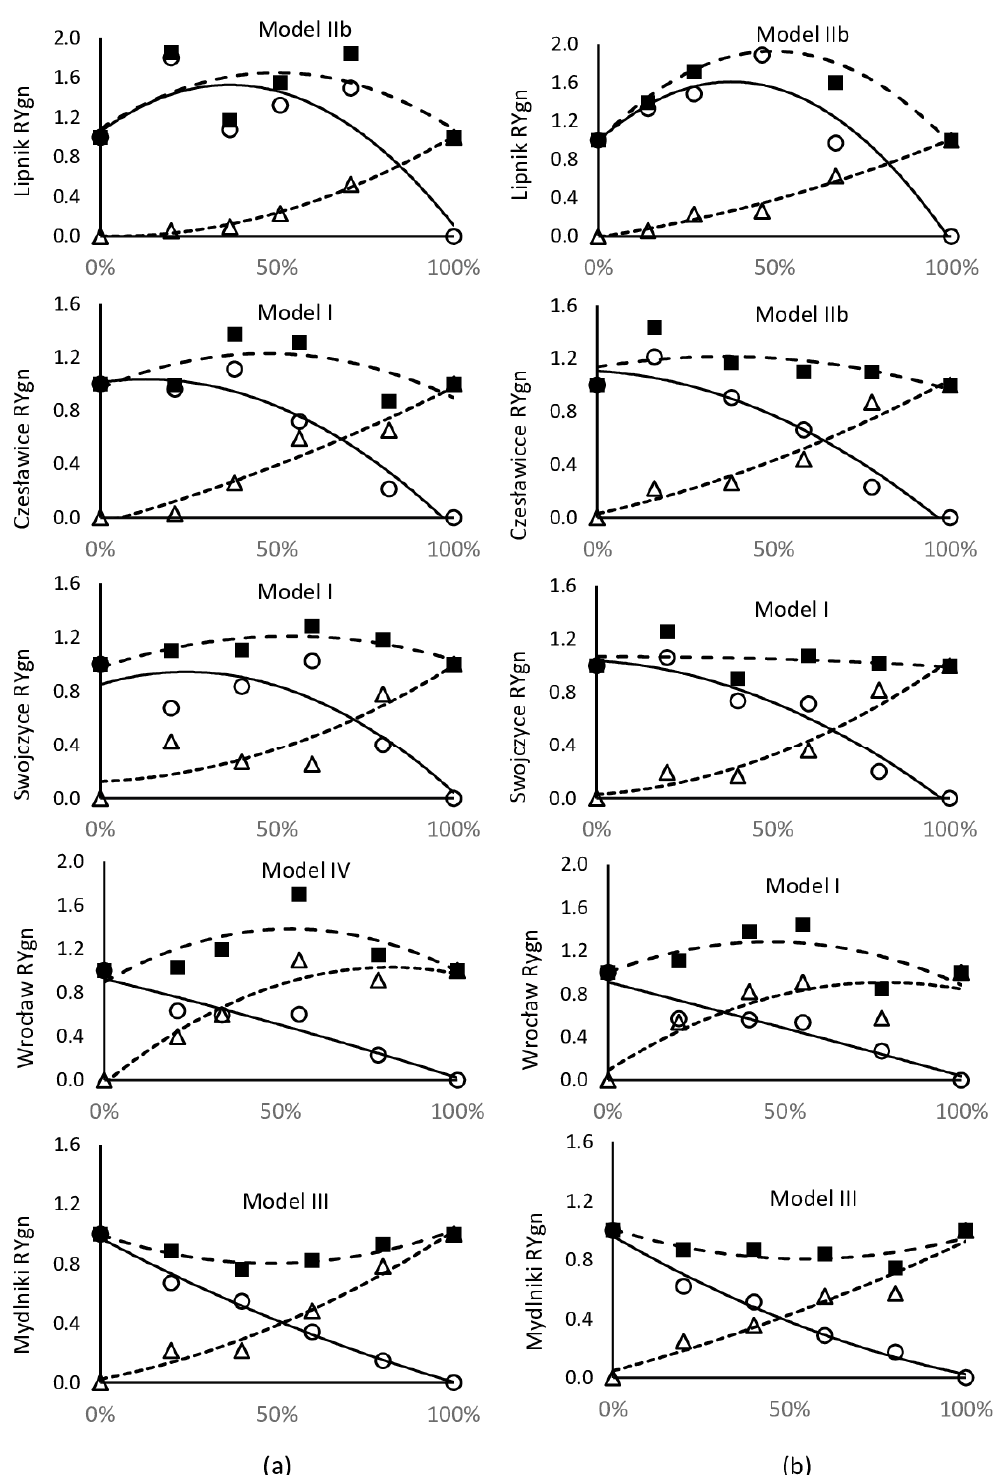
Figure 8. The replacement competition model for the relative seed number (RYse) of winter wheat and cornflower (B) in the 2018–2019 season (classified according to the t -test and p < 0.05). ( a ) competition between WW and B resistant (R) and ( b ) competition between WW and herbicide- susceptible cornflower (S). Legend: o—WW; ∆ —R ( a ) or S ( b ), □ —WW + R ( a ) or WW + S ( b ).